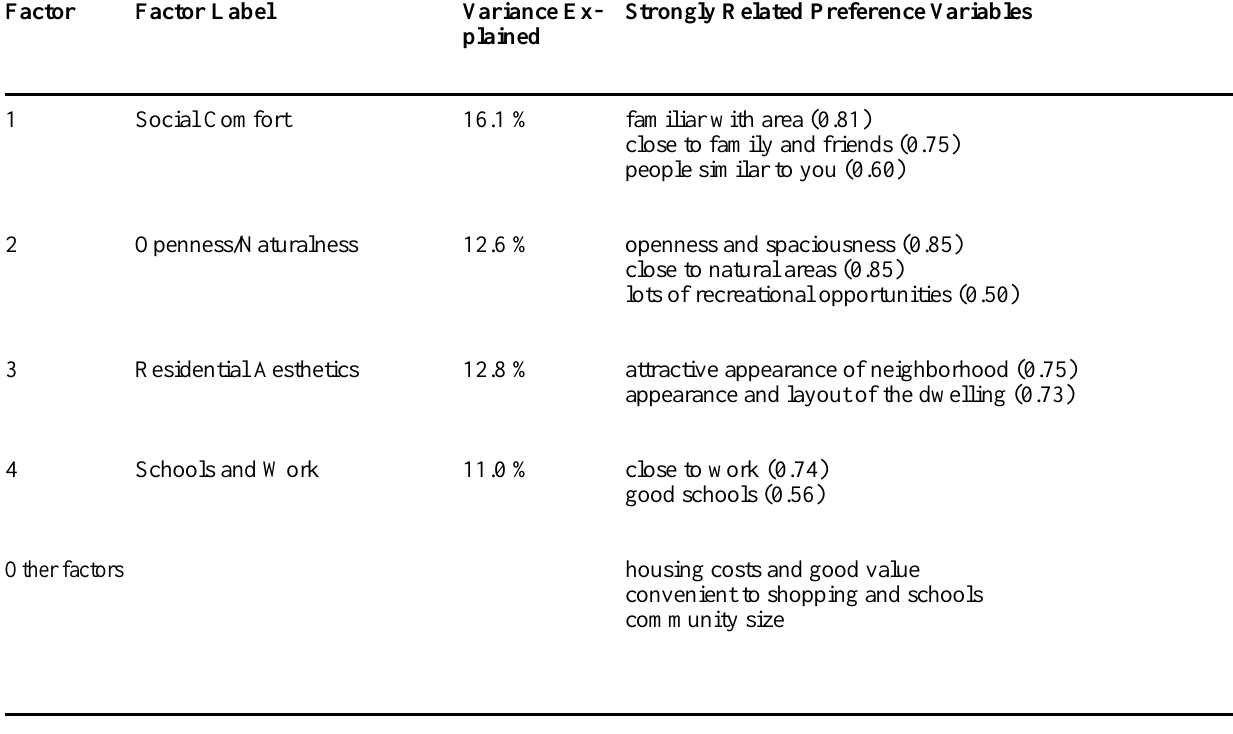
Table 1. Preference factors from the analysis of the survey data (Fernandez et al. 2005), with percent of variance explained by each. Numbers in parentheses indicate the loading of strongly related variables, i. e., those loading 0.5 or higher, on each factor. All variables not loading greater than 0.5 on any one variable are listed under "other factors." All variables used in the analysis are listed